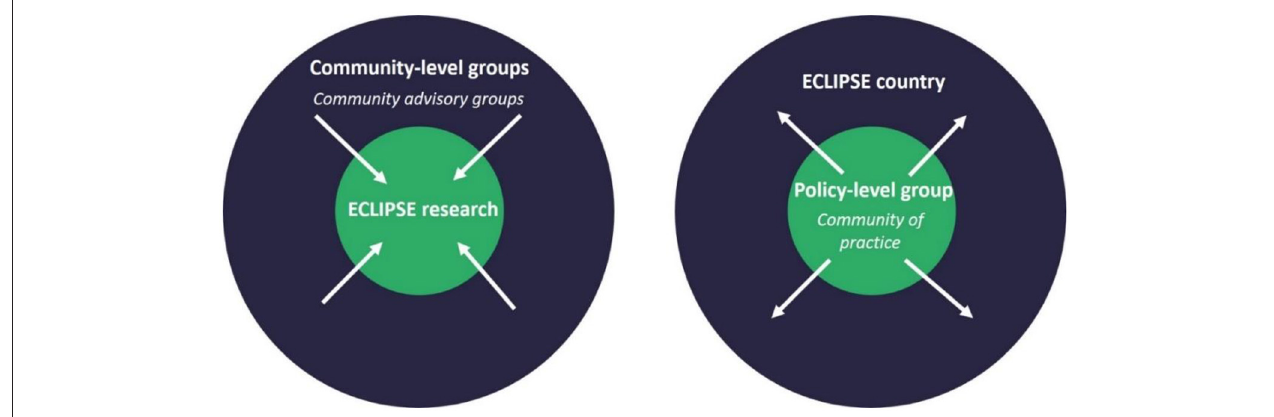
FIGURE 1 | Community engagement strategy in